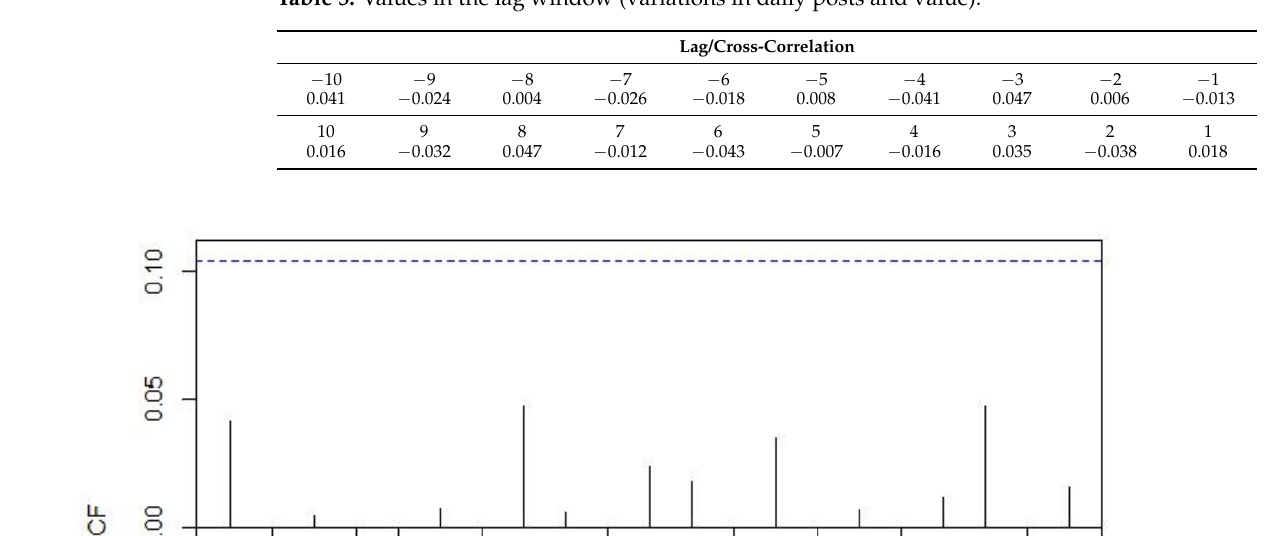
Table 5. Values in the lag window (variations in daily posts and value).